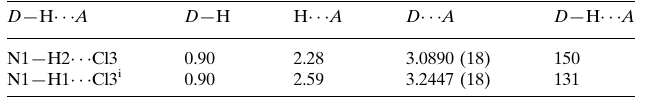
Related literature For a related structure, see: Froimowitz et al. (1998).